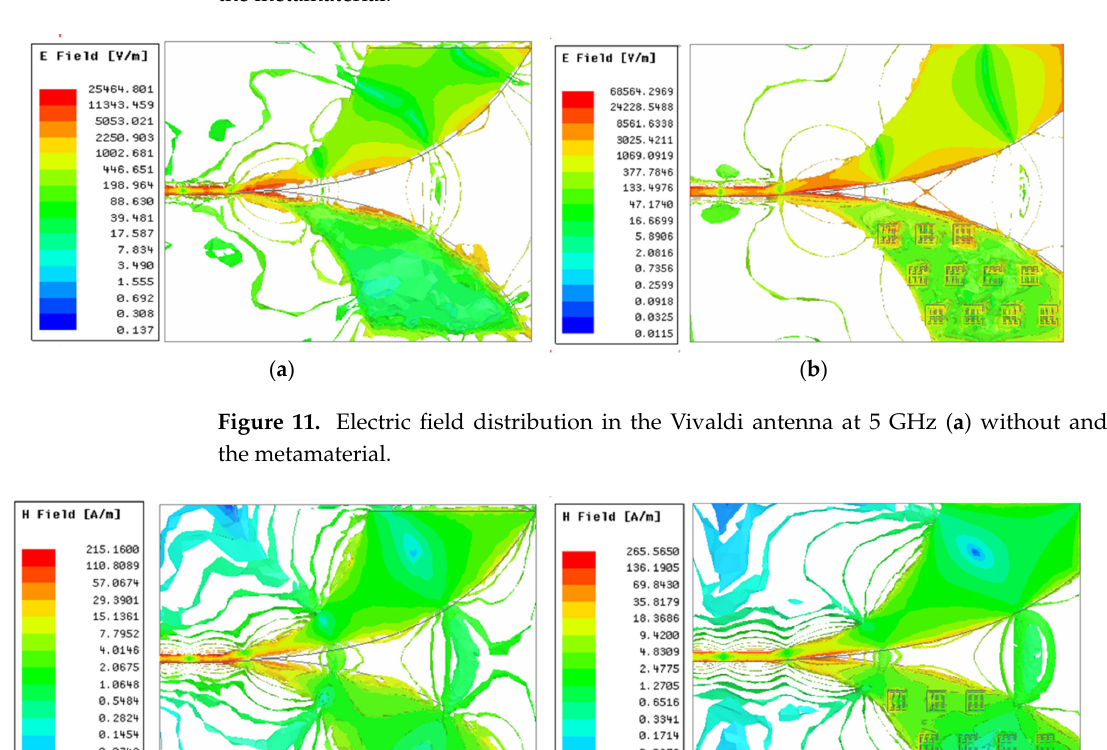
Figure 13. Measurement of the gain in the anechoic chamber.